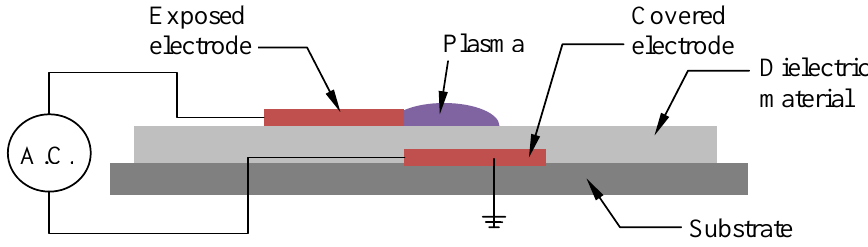
Figure 1. Schematic of the basic configuration of a dielectric barrier discharge (DBD) plasma